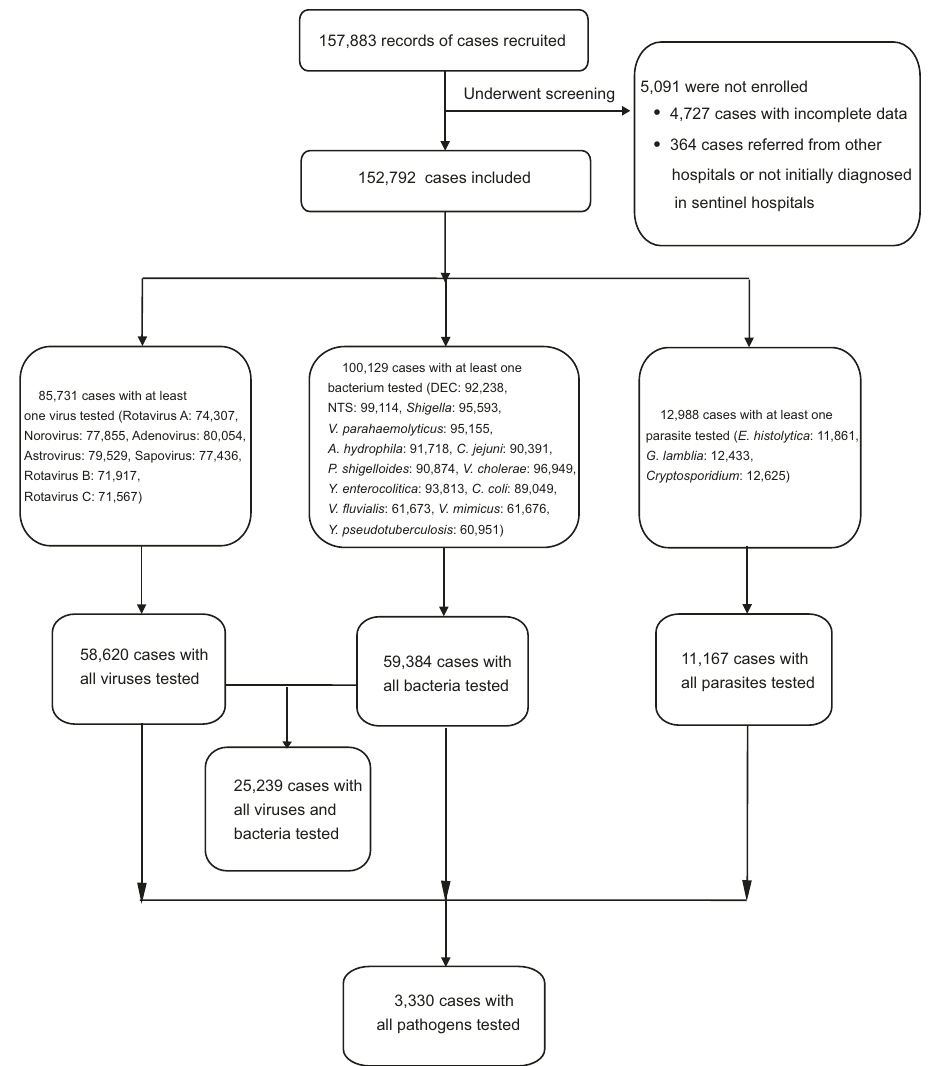
Fig. 1 A fl owchart of the data collection and sorting procedures. This fl ow diagram summarizes the number of patients with acute diarrhea for each analysis in this